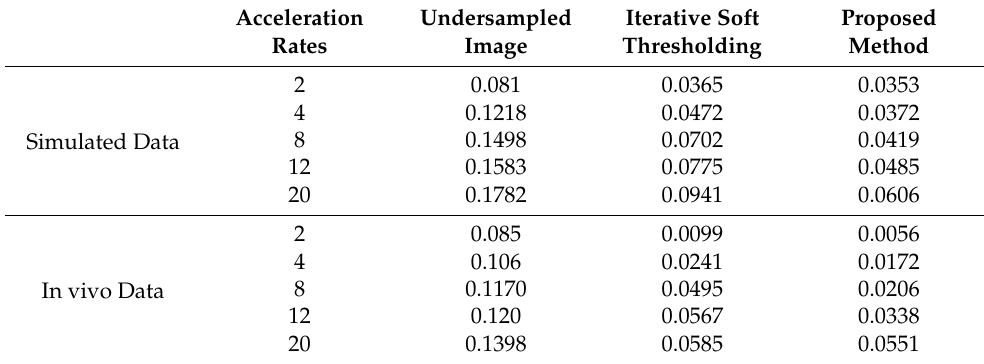
Figure 16. In real vivo data ( a ) Compares proposed method at bottom row with IST at top row with acceleration rate of 2. The arrow in (a) shows very minute artifacts. ( b ) depicts the performance of proposed method at acceleration rate equal to 4. The arrow in ( b ) depicts the presence of artefacts ( c ) shows the results of both algorithms with acceleration rate set at 8. The artefacts due to subsam- pling become gradually more visible in IST results as highlighted by arrow mark ( d ) depicts the results when acceleration rate is set at 12. Both techniques depicts the artefacts, however these arte- facts are visible in the IST as mentioned by the white arrow in the figure ( e ) show very much de- graded image quality of IST, while comparing it with the proposed method. The subsampling arte- facts dominate the traditional IST result when acceleration rate R is set at 20.